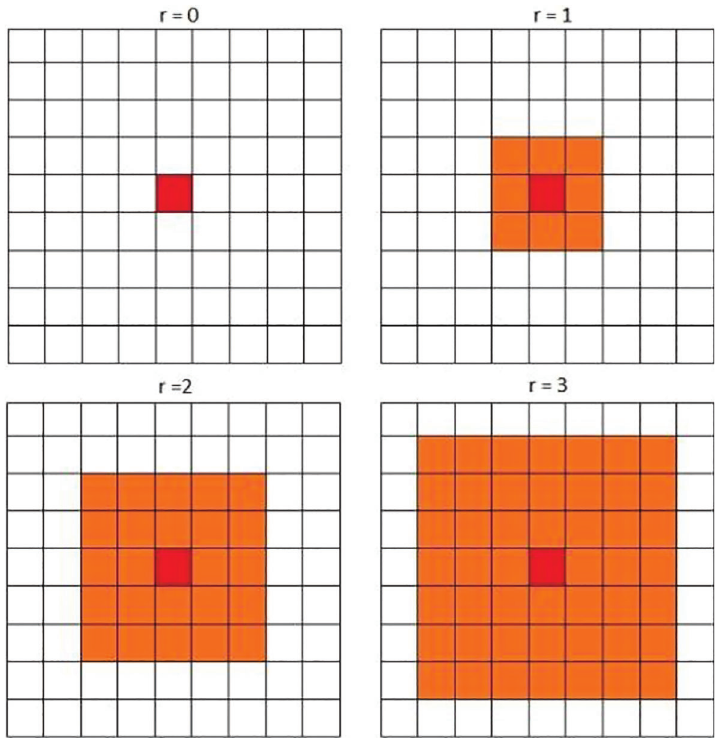
Figure 6. Moore neighborhood for r=0, r =1, r=2, and r=3. r: